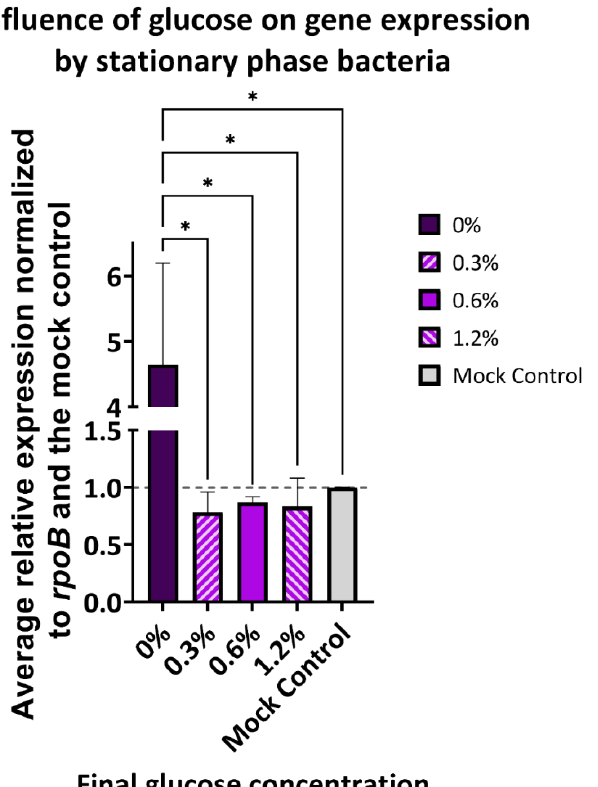
Figure 5. Varying glucose concentrations do not significantly alter flgB expression in E. cloacae following incubation with MNV. Differences in gene expression were measured via qPCR when MNV interacts with E. cloacae in the stationary growth phase. Relative expression and significance are measured against gene expression of a mock control of E. Cloacae without MNV, signified by a dashed line at y = 1 and the mock control column. (* = p ≤ 0.05). The error bars show SEM; n = 3.